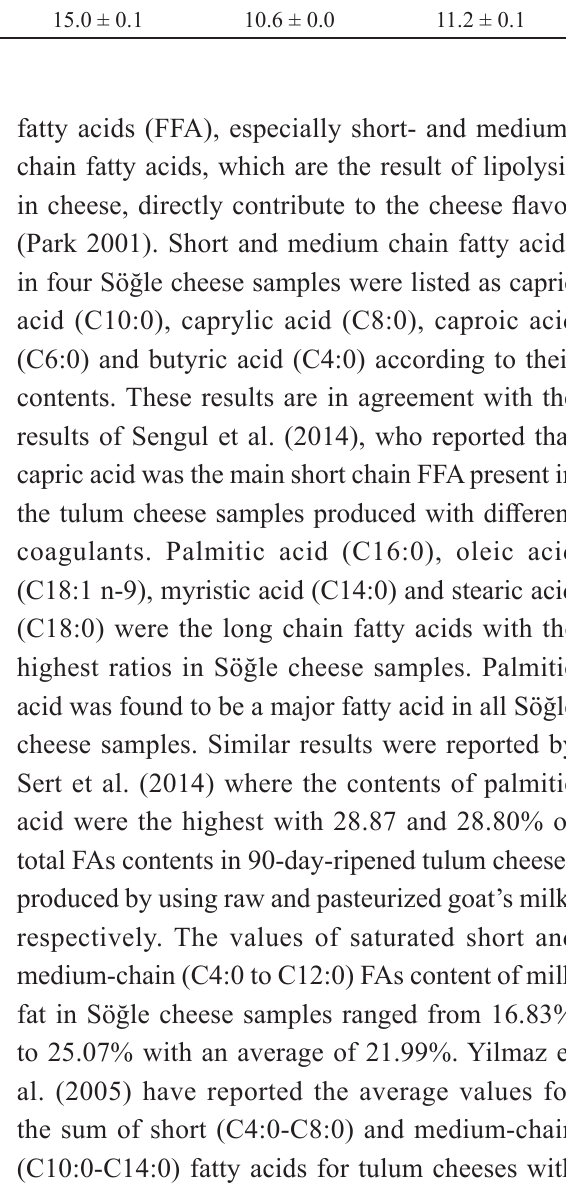
Physicochemical characteristics of Söğle cheese samples ripened for three months (n = 2) * . Analysis